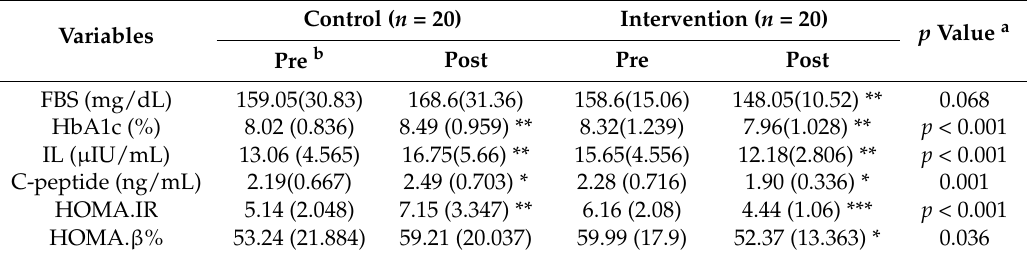
Table 2. Differences in the glycemic control indicators between the